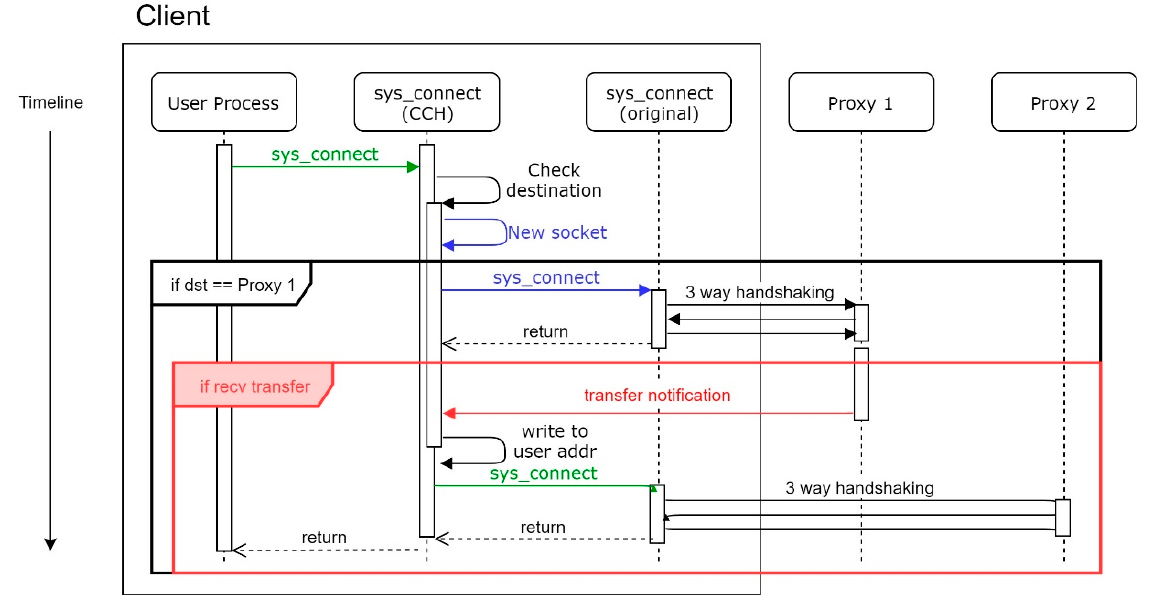
Figure 9. Workflow of CCH when the Proxy 1 is under attack.